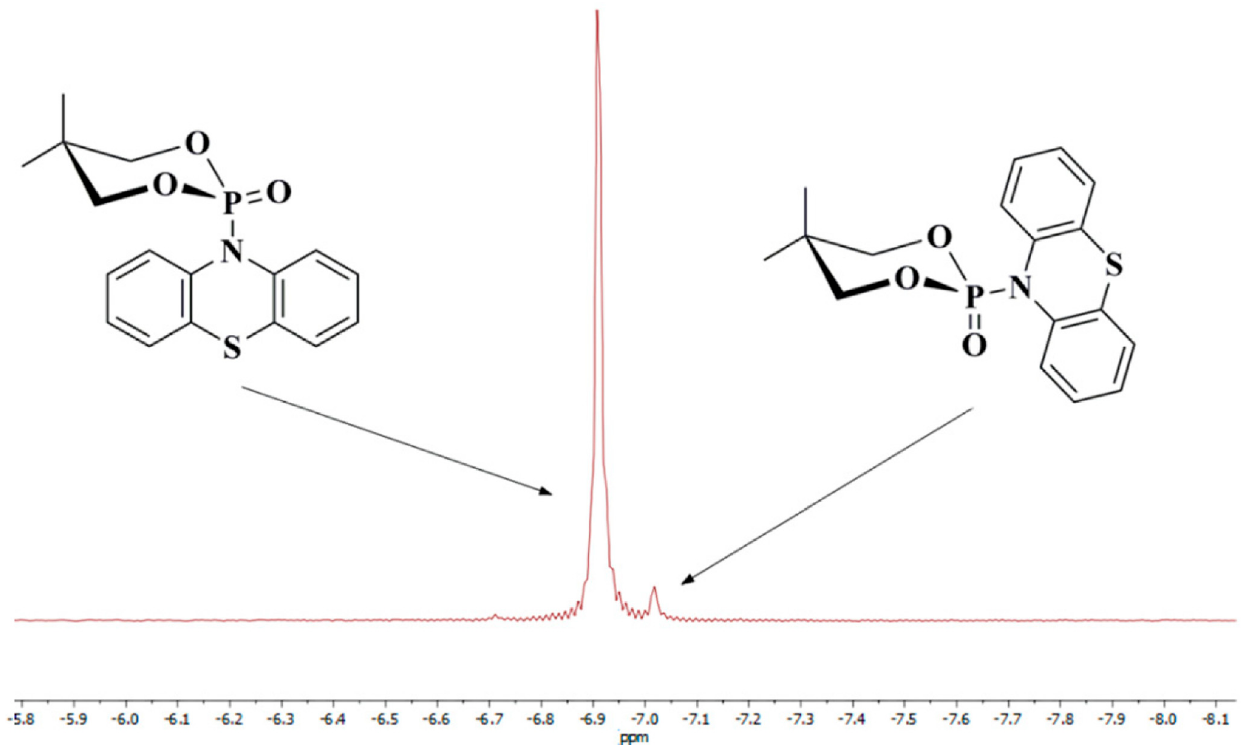
Figure 7. 31 P{ 1 H} − NMR spectrum for molecule 2a (two chair conformers) in CDCl 3 .